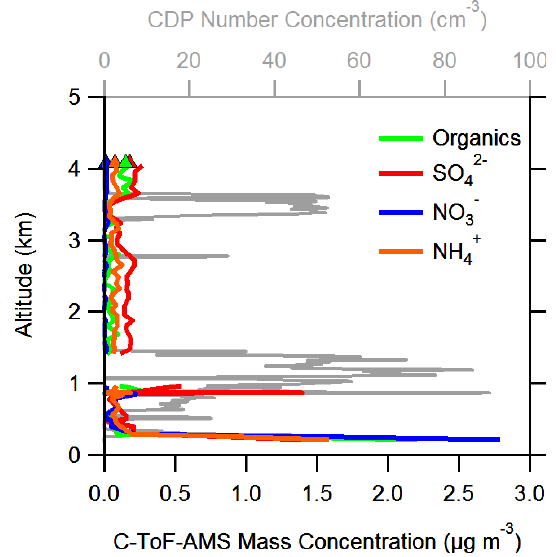
Fig. 13. Vertical profile of mass concentration for submicron aerosol species from the C-ToF-AMS. Cloud droplet number con- centrations (measured by the CDP) are also shown on the top